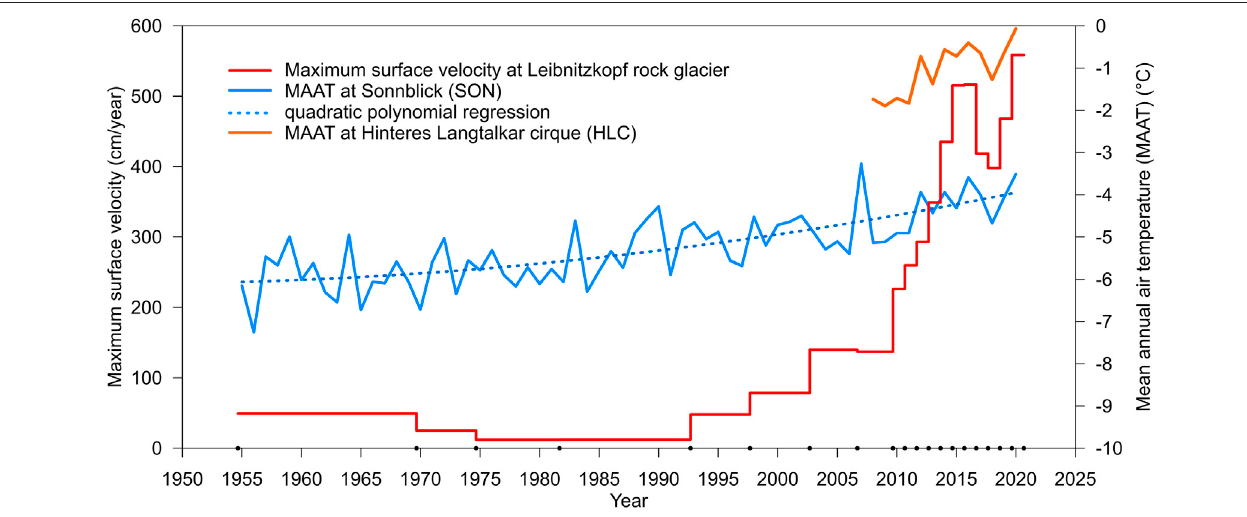
FIGURE 6 | Velocity-time graph showing maximum speed values measured photogrammetrically and geodetically. Points on the x-axis indicate dates of data acquisition. This plot also shows the mean annual air temperature (MAAT) of SON (1954 – 2020) and HLC (2007 – 2020).